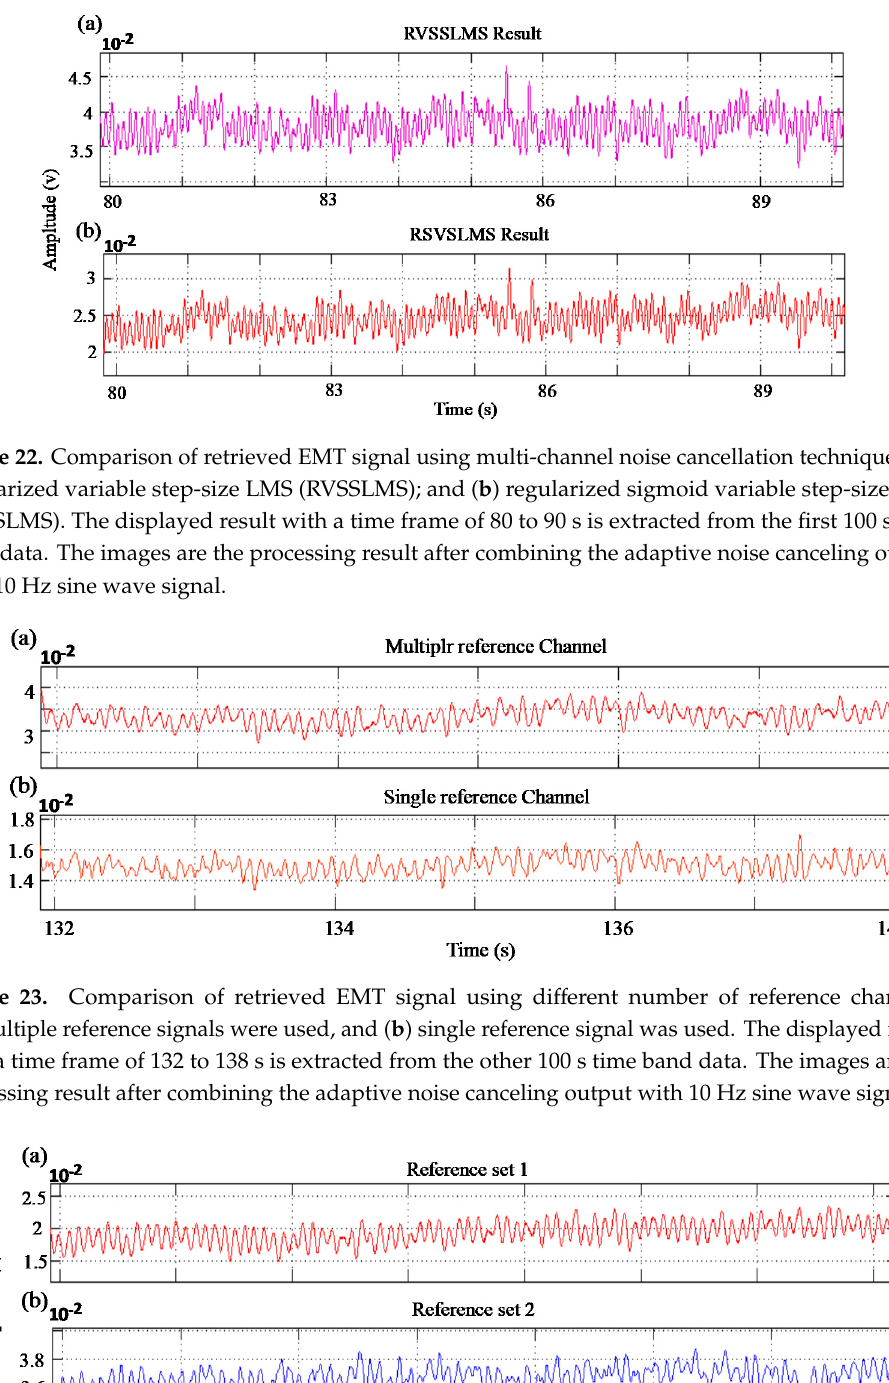
Figure 21. Comparison of retrieved EMT signal using multi-channel noise cancellation techniques: ( a ) regularized variable step-size LMS (RVSSLMS); and ( b ) regularized sigmoid variable step-size LMS (RSVSLMS). The displayed result with a time frame of 50 to 60 s is extracted from the first 100s time band data. The images are the processing result after combining the adaptive noise canceling output with 10Hz sine wave signal.